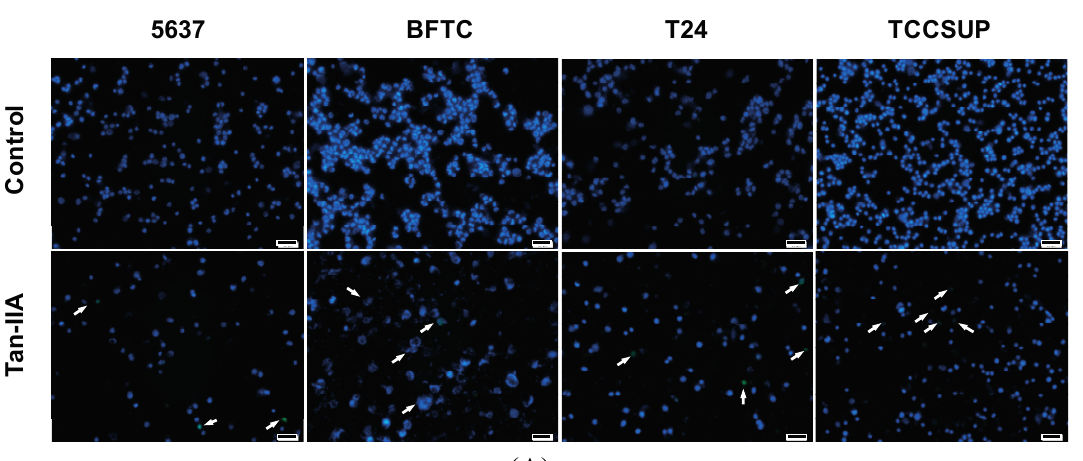
Figure 3. Tan-IIA induced mitochondria dependent apoptosis in human bladder cancer cells. ( A ) Human bladder cancer cells were treated with 0.2% DMSO (control) or 2 μ g/mL Tan-IIA for 72 h and then were fixed and stained with the TUNEL assay. Nuclei were stained with DAPI. TUNEL positive cells were indicated by arrows. Scale bar: 50 μ m; ( B ) Human bladder cancer cells were treated with 4 μ g/mL Tan-IIA for 0 to 72 h, and western blot analysis were performed for cleaved caspase 9 and cleaved caspase 3. β -actin was used as an internal control; ( C ) Human bladder cancer cells were treated with increasing concentration of Tan-IIA (1 to 4 μ g/mL) for 48 h, followed by western blot analyses for cleaved caspase 9 and cleaved caspase 3. β -actin was used as an internal control; ( D ) MTT assay of human bladder cancer cells pretreated with caspase 3 inhibitor Z-DEVD-fmk (10 or 20 μ M) for 1 h and then treated with or without 2 μ g/mL Tan-IIA for 48 h. The values are the mean ± S.D. from three independent experiments. * p < 0.05 versus